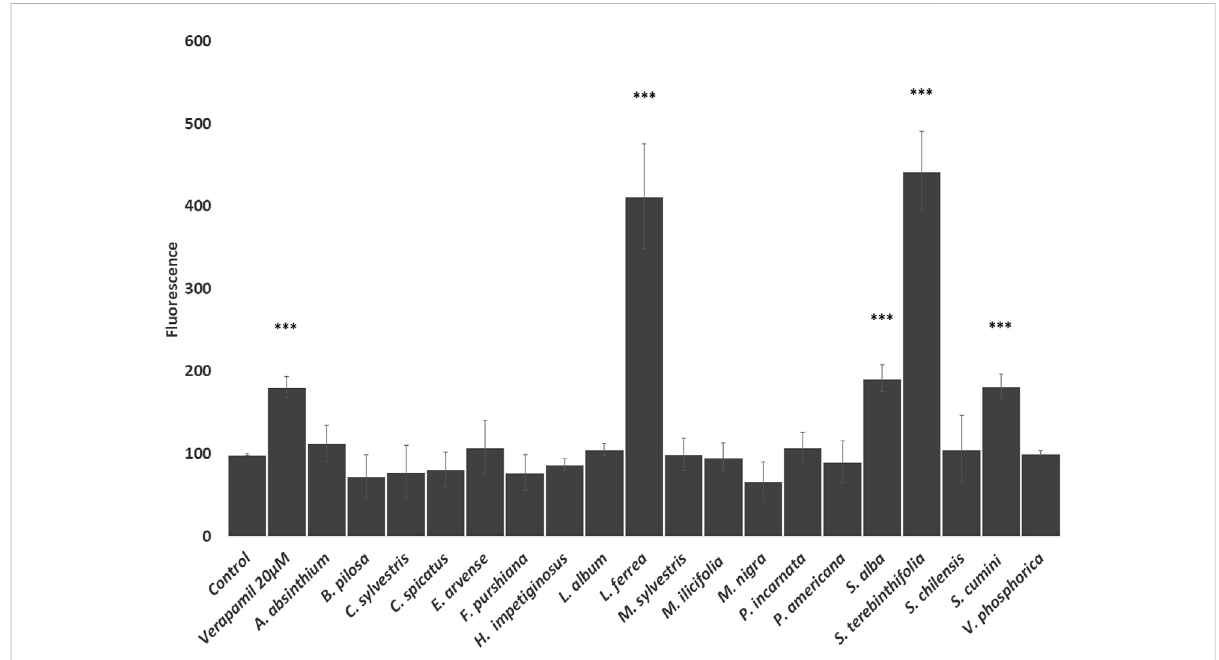
FIGURE 1 Effects of the selected herbal preparations (100 μ g/ml, except S. alba 10 μ g/ml) and Verapamil (positive reference treatment) on the ef fl ux activity ofP-gpinCaCo2 VCRcells (Mean ± SEM, n ≥ 3). Statisticalsigni fi cance against water (control) according to Bonferroni (* p < 0.05, ** p < 0.01, *** p <